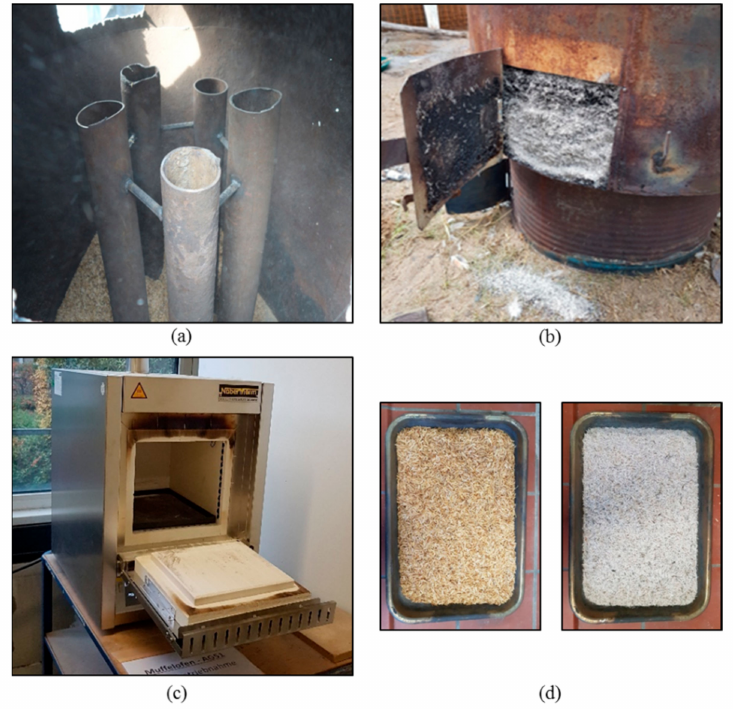
Figure 2. Di ff erent combustion methods: ( a ) pipes in a self-made furnace; ( b ) rice husk ash (RHA) after combustion; ( c ) controlled laboratory combustion in a mu ffl e oven and ( d ) RH before (left) and after (right) controlled